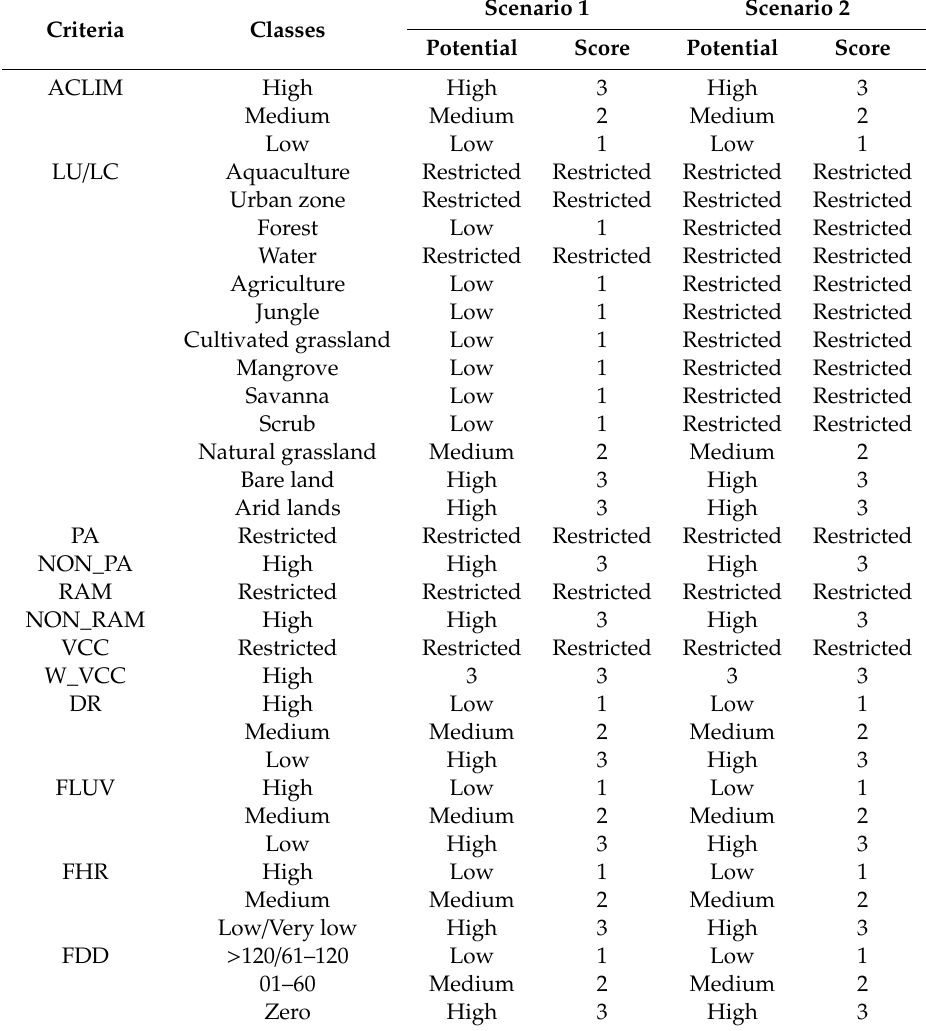
Table 4. AEZ criteria for JCL cultivation. Variables and scores of the two scenarios. Criteria Classes